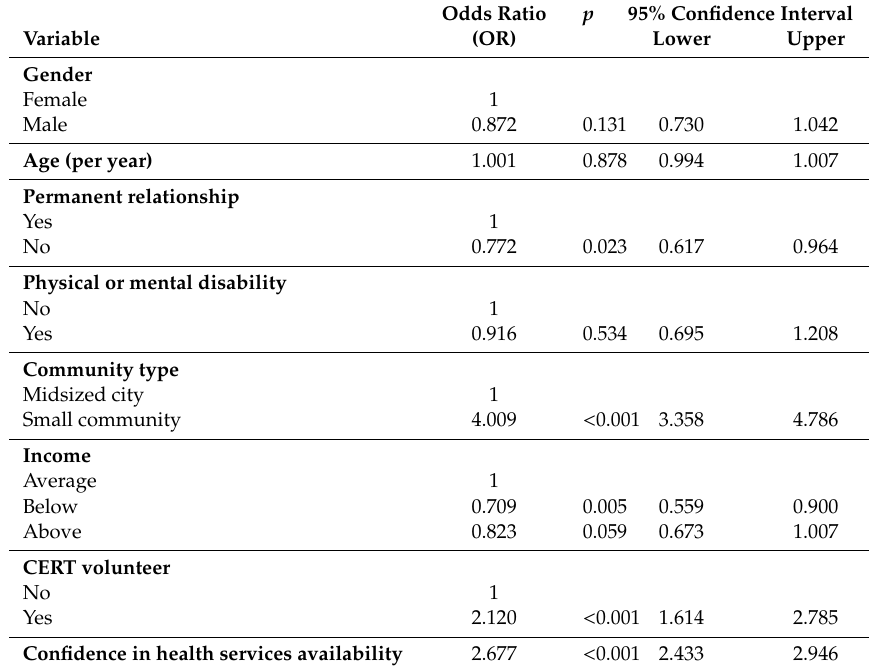
Table 2. Association between covariates and CCRAM score, logistic regression model.